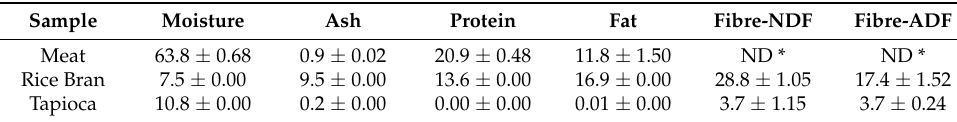
Table 1. Analysed proximate composition (%) of goat meat, rice bran, and tapioca used to make goat meatballs (‘bakso’).